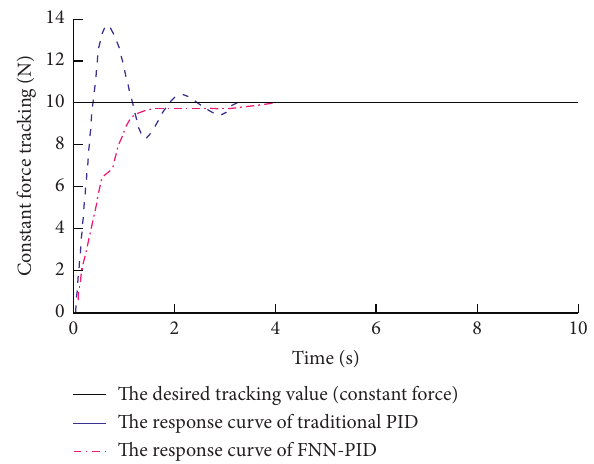
Figure 7: Comparison of response curves of two control strategies.